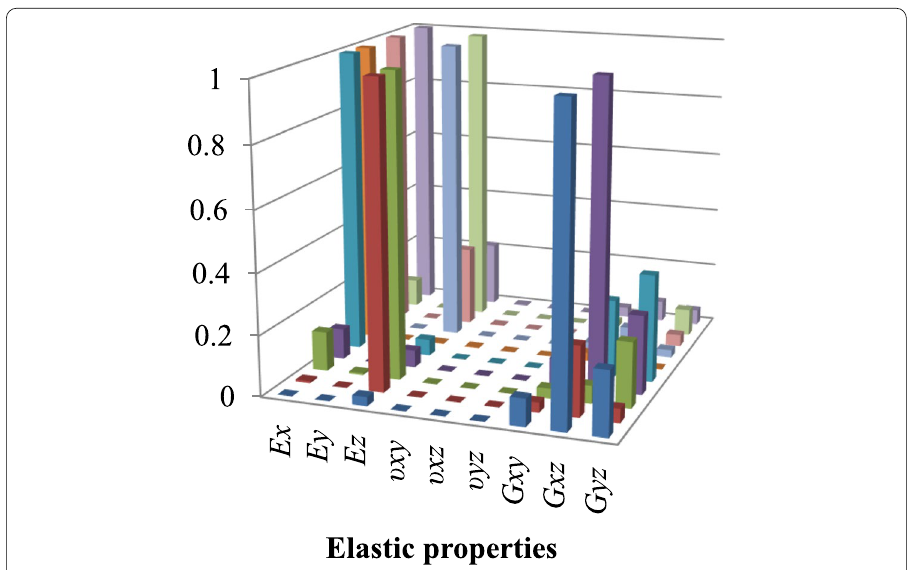
Fig. 21 Sensitivity analysis for